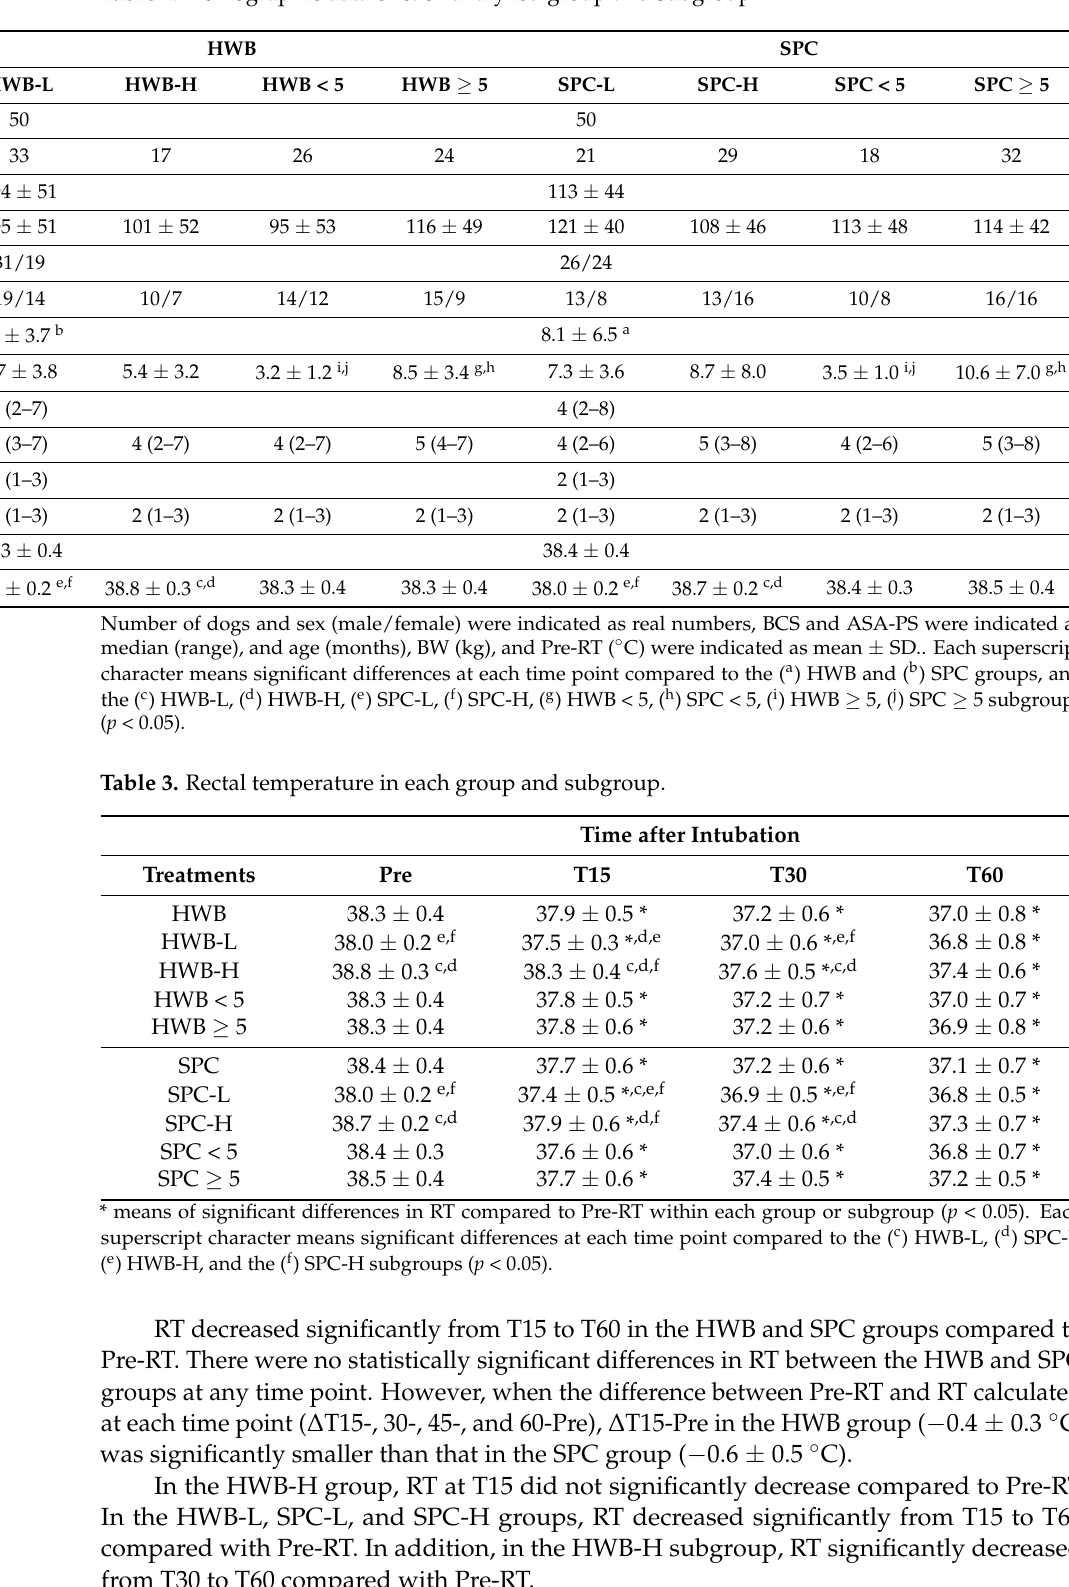
Table 2. Demographic data of each analyzed group and subgroup.